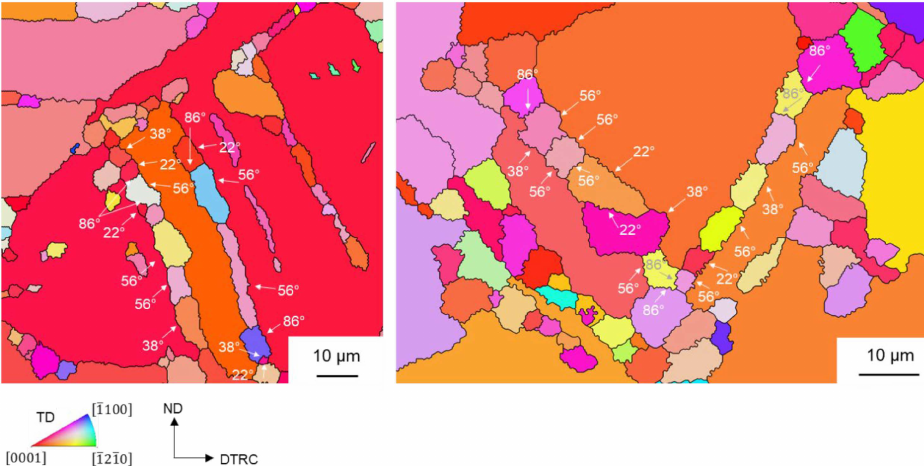
Figure 4. Misorientation relationships between the matrix and grains recrystallized in the twins after hot compression at an equivalent logarithmic strain of 0.6 under a strain rate of 10 s − 1